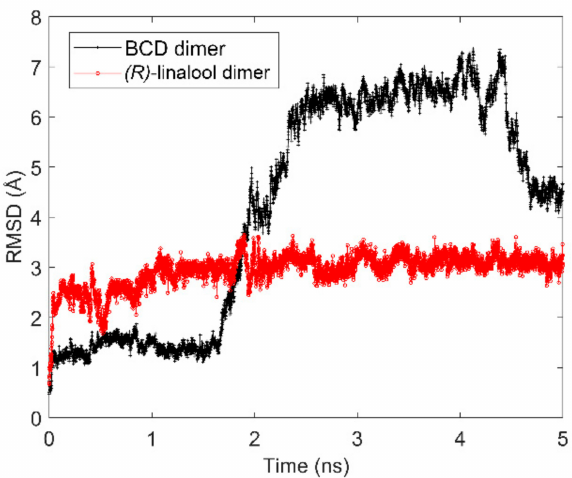
Figure 6. RMSD plot of ( R )-linalool/BCD dimeric complex during 5 ns of MD simulation.